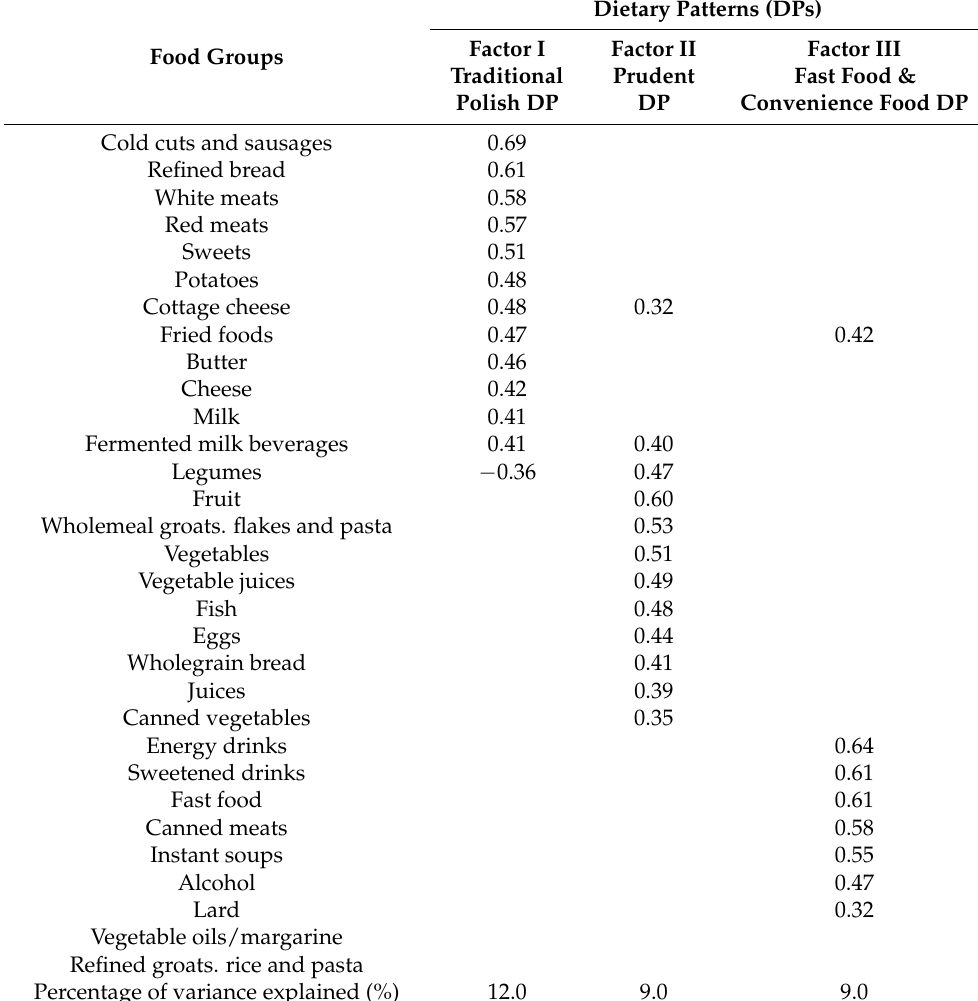
Table 3. Factor-loading matrix for major dietary